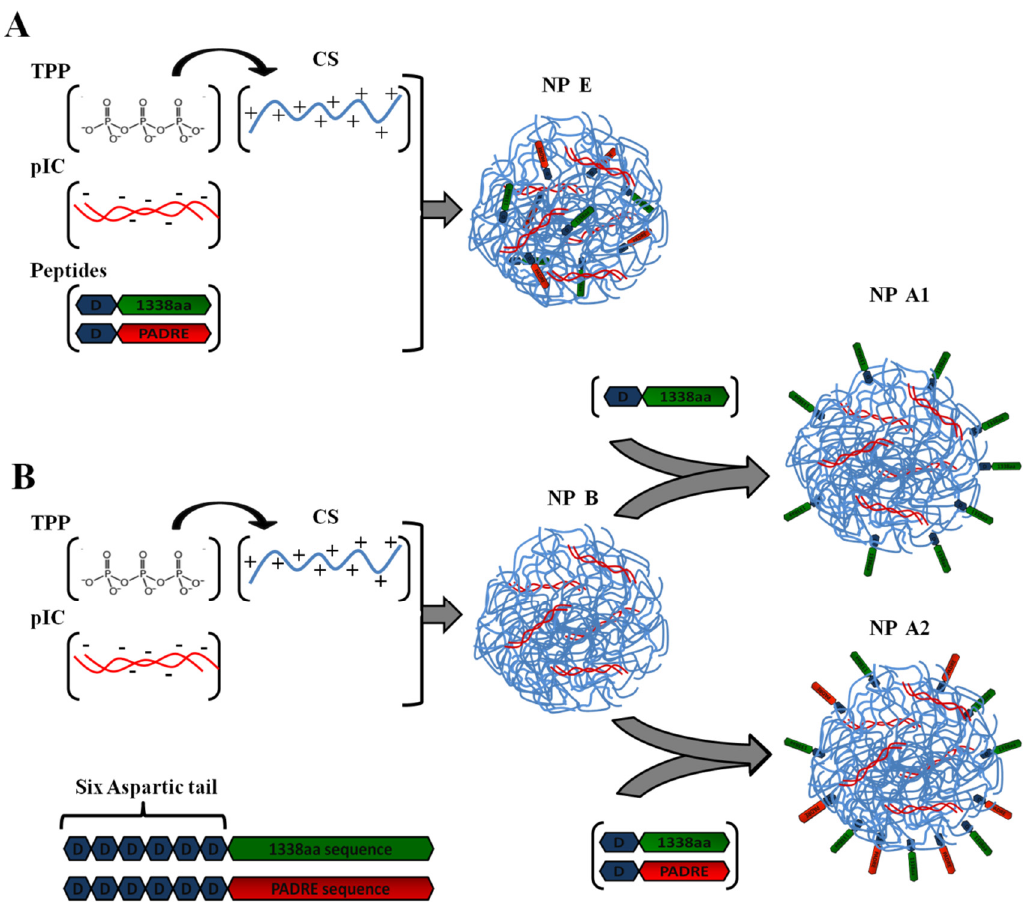
Figure 1. Illustration of peptide-loading into nanoparticles either by encapsulation of both peptides to generate the formulation NP E ( A ); by adsorption of 1338aa or of 1338aa and PADRE to generate the formulation NP A1 and NP A2, respectively ( B ). Representation of both peptides, divided in their active part (1338aa sequence and PADRE sequence) and its six aspartic acid segment designed to promote their interaction with the CS amino